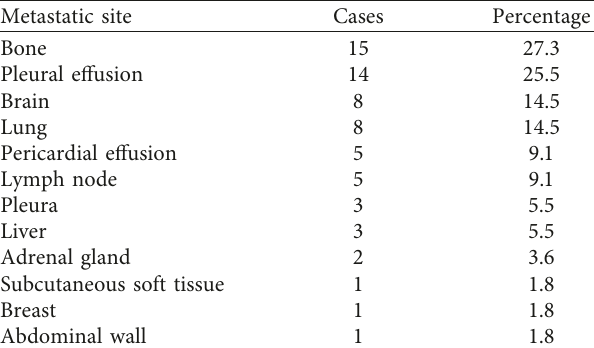
Table 2: The characteristics of the 55 young NSCLC patients with distant metastasis.